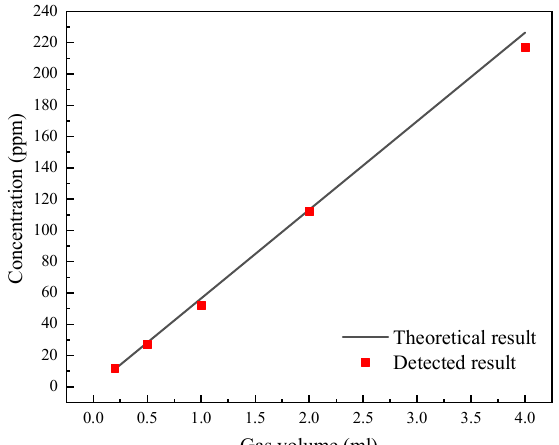
Figure 3. CO concentration calibrated with an electrochemical gas detector as a function of CO gas volume added into the gas chamber.